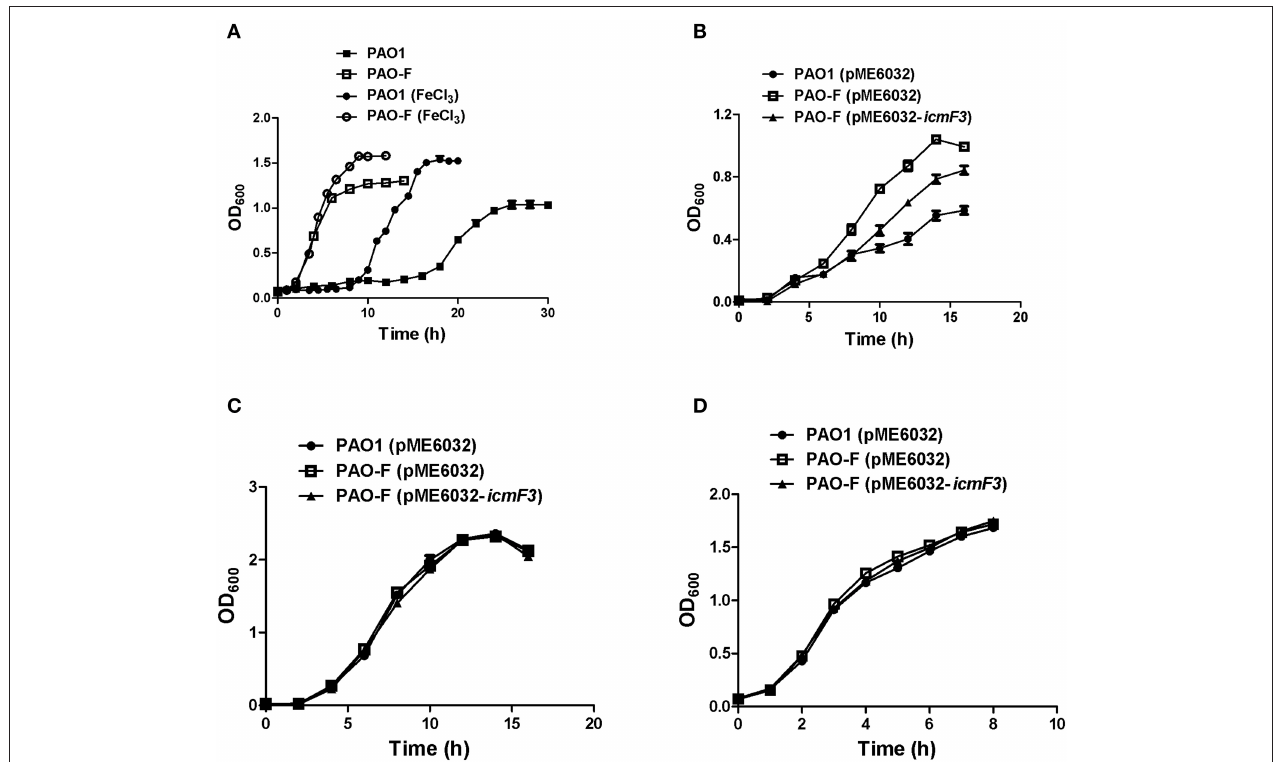
FIGURE 4 | Growth curves of P. aeruginosa in LB and iron-limiting media at 37 ◦ C. (A) P. aeruginosa PAO1 and PAO-F were cultured in CAA alone or CAA supplemented with 200 µ M FeCl 3 and growth was measured as a function of time. (B–D) Growth of P. aeruginosa PAO1 with pME6032, PAO-F with pME6032,